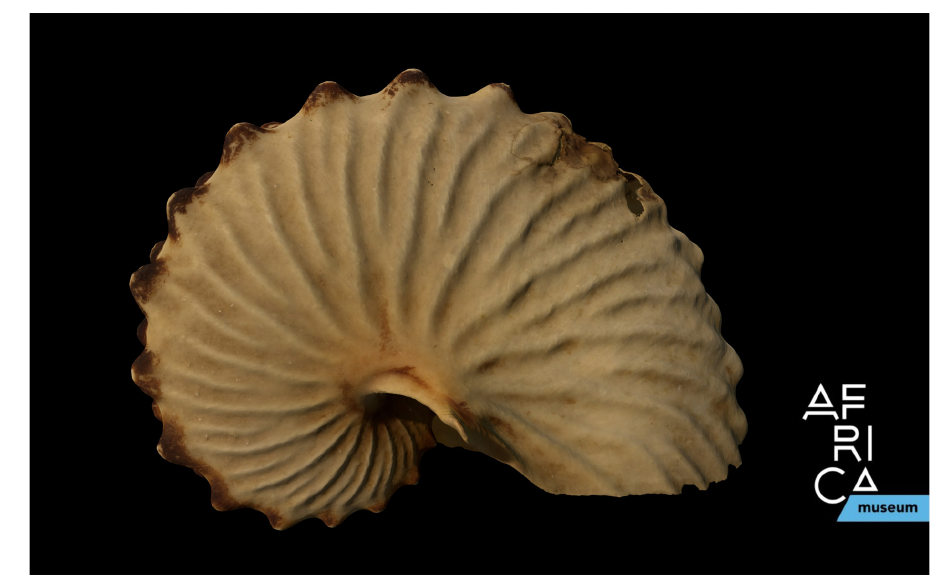
Fig. 3.9. Example of photogrammetry model of Argonauta tuberculata https://sketchfab.com/models/daed659ee685452b91d8f8c91dff761b